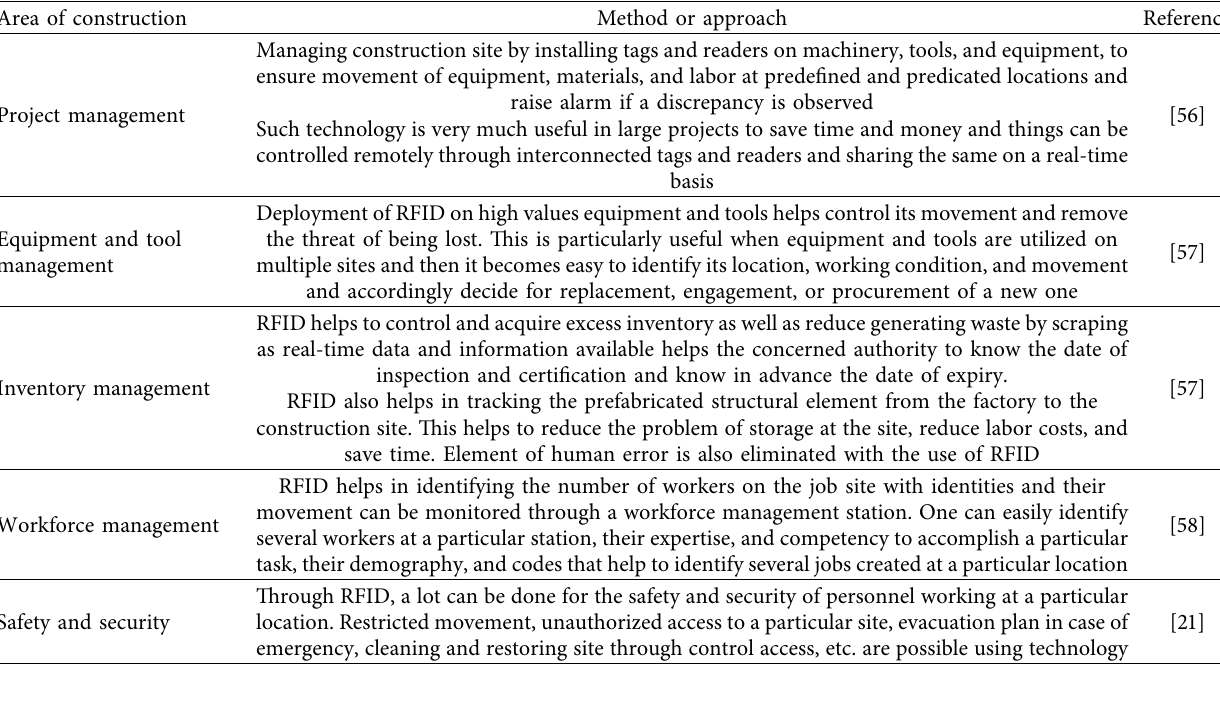
Table 3: RFID technology in major fields or areas of the construction